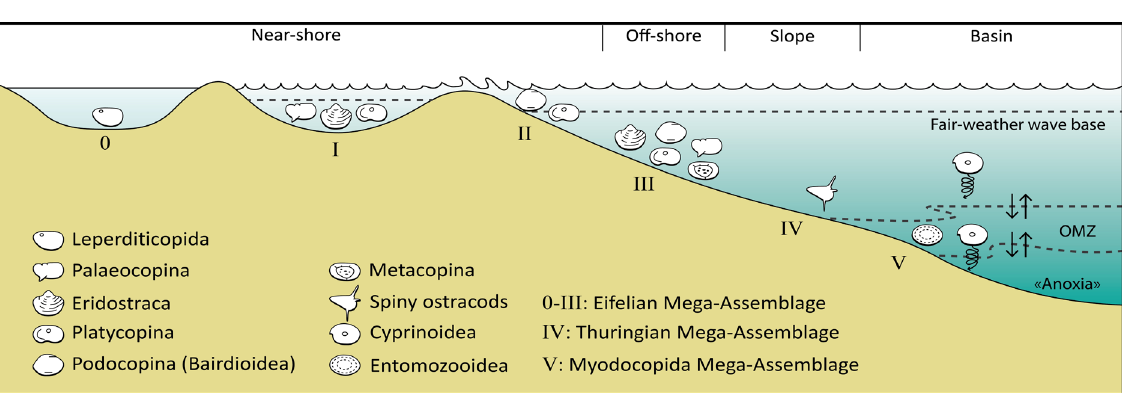
Fig. 14. Location of the different ostracod mega-assemblages along the platform (modified from Crasquin & Horne 2018; redrawn, with minor modifications, from Casier